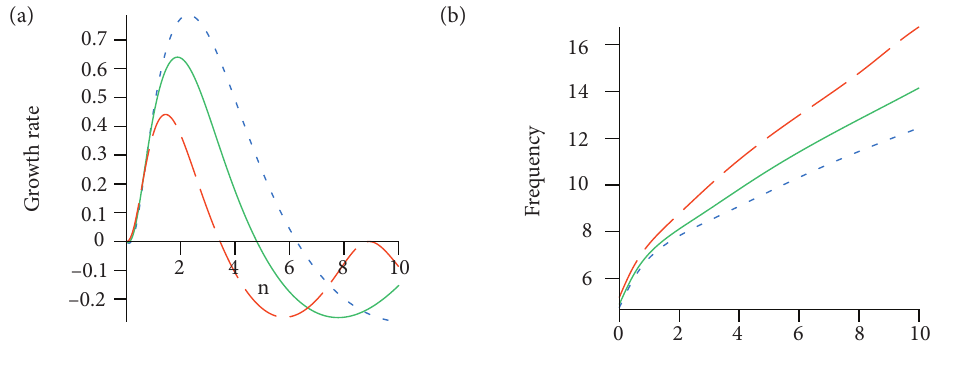
Figure 20. Thermoacoustic characteristics of a ducted resonator as resonator frequency